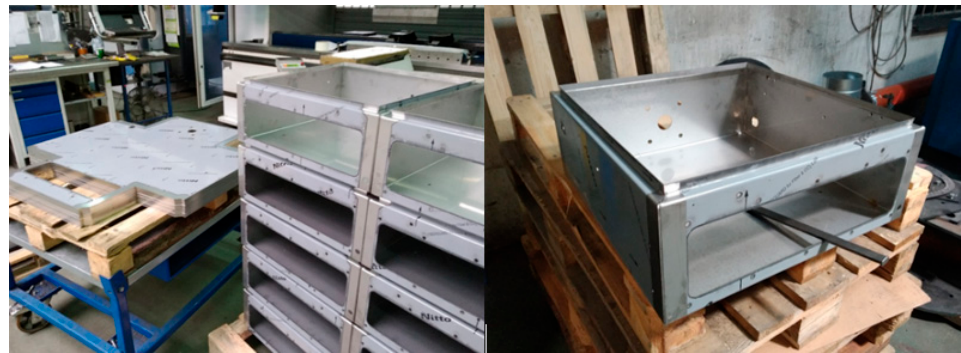
Figure 1. Photos of the welded detail.